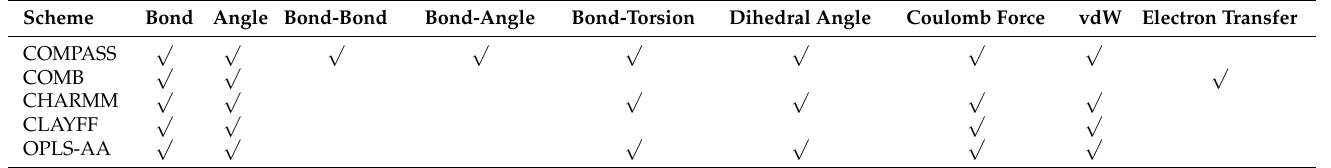
COMPASS: Condensed-phase Optimized Molecular Potentials for Atomistic Simulation Studies, Sun. [72,73]; COMB: Charge Optimization Many Body, Allen et al. [74]; CHARMM: Chemistry at HARvard Macromolecular Mechanics, Brooks et al. [75]; CLAYFF: CLAY force field, Cygan et al. [52]; OPLS-AA: Optimized Parameters for Liquid Simulations All Atom, Jorgensen et al.